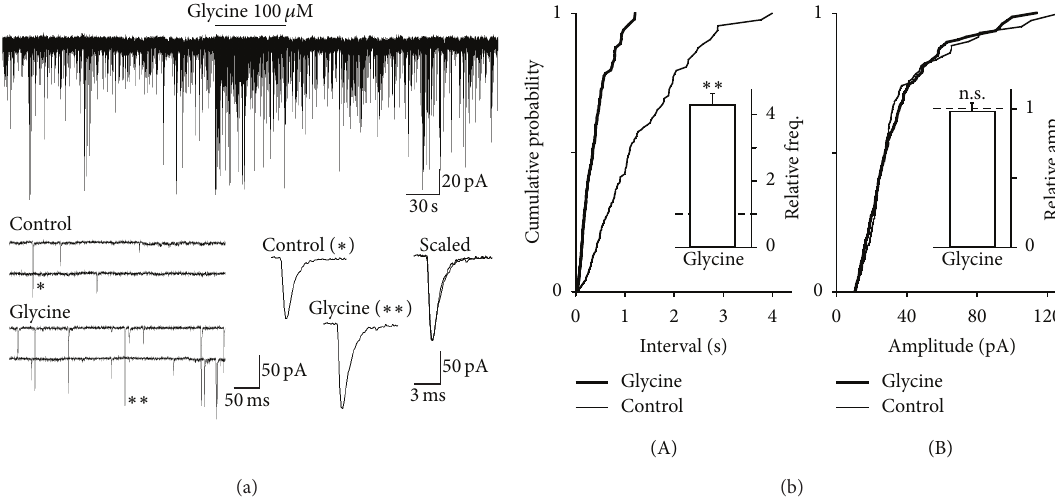
Figure2:EffectsofglycineonglutamatergicsEPSCs.(a)AtypicaltraceofglutamatergicsEPSCsobservedbefore,during,andafterapplication of 100 𝜇 M glycine. Insets represent typical traces with an expanded time scale (left) and single sEPSCs indicated by symbols (right). (b) Cumulative probability distribution for interevent interval (A) and current amplitude (B) of glutamatergic sEPSCs. 191 for control (thin lines) and 292 events for glycine (thick lines) were plotted. Insets column represents mean and SEM from 12 neurons. Dotted lines represent the relative control of basal frequency and amplitude of sEPSCs. ∗∗ 𝑃 < 0.01 ; n.s.: not significant.